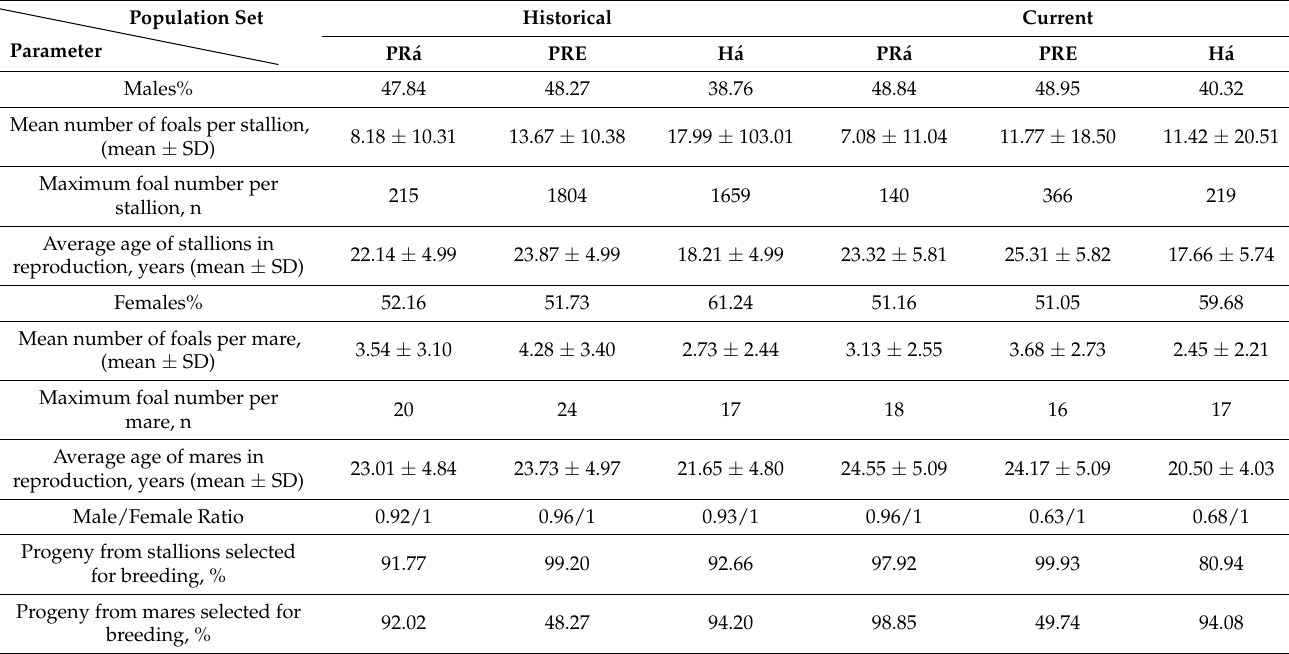
Table 2. Summary of the statistics derived from pedigree analysis including maximum progeny per stallion and mare, mean age of stallions and mares in reproduction and foals of stallions and mares selected for breeding in the historical (n = 207,100) and current (n = 164,941) Arabian Purebred (PR á ), Spanish Purebred (PRE) and Hispano-Arabian (H á ) horse breed